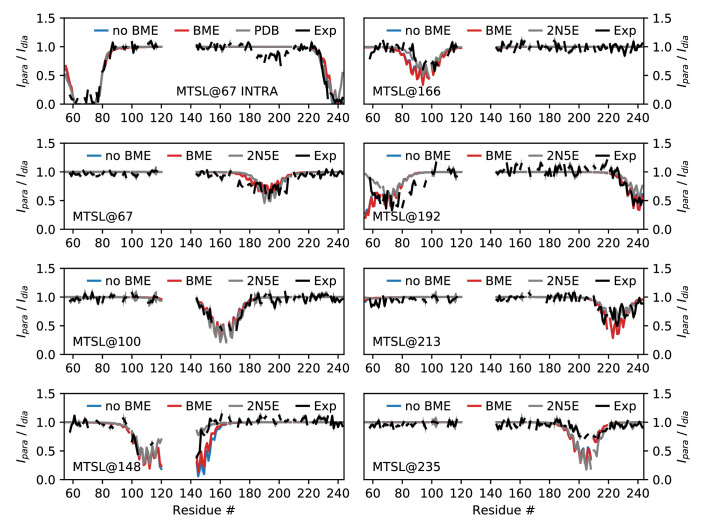
Comparing MD simulations with PRE data.Each panel corresponds a different probe position as indicated by the labels. We show the experimental values (black), those calculated from the structure determined using these and other data (grey) and our MD simulations both before (blue) and after (red) reweighting. For many probe positions and residues, the values calculated from the PDB structure and our simulations are very similar, so that the colored lines appear hidden beneath the grey line.